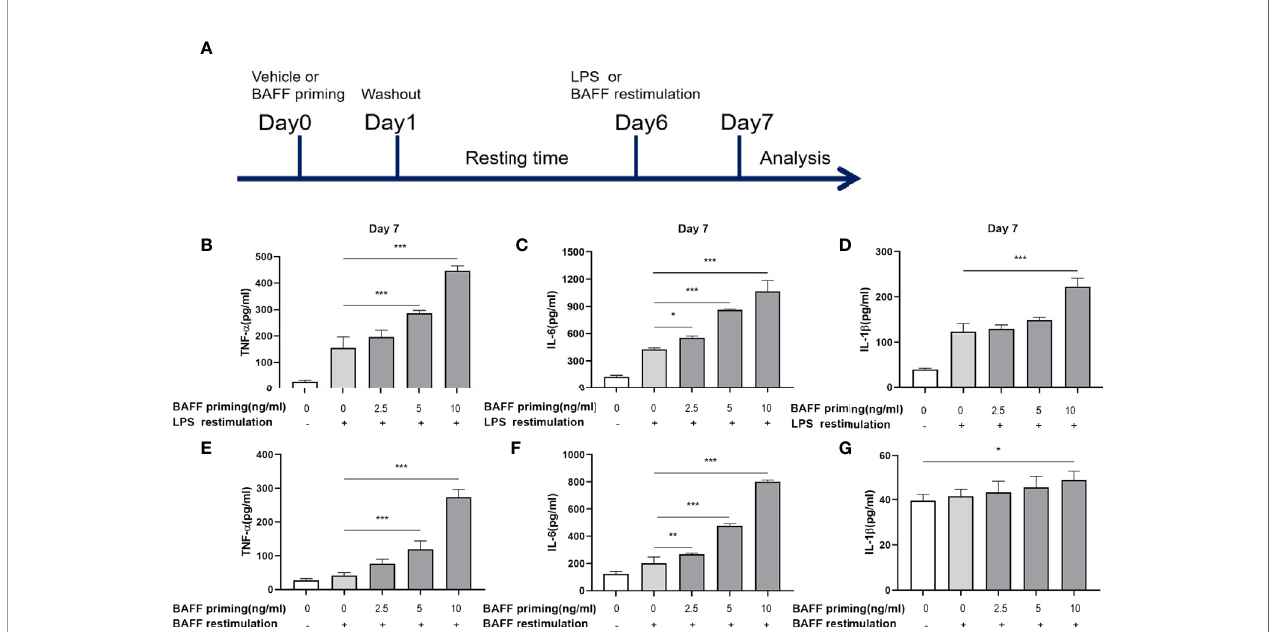
FIGURE 1 | BAFF priming induced a proin fl ammatory memory response of BV2 cells to LPS and BAFF itself. (A) Graphical outline of the in vitro methods. BV2 cells or primary mouse microglial cells were incubated for 24 h with vehicle or BAFF (de fi ned as ‘ BAFF priming ’ ), and after a 5-day rest period, microglial cells were restimulated with 40 ng/ml BAFF (BAFF restimulation) or 100 ng/ml LPS (LPS restimulation) for 24 h. In (B – D) , BV2 cells were primed with different doses of BAFF (2.5, 5, 10 ng/ml) or vehicle for 24 h, rested for 5 days, on day 6 treated with LPS restimulation for 24 h. TNF- a (B) , IL-6 (C) , and IL-1 b (D) were measured in the supernatants by ELISA on day 7(n = 12). On day 6, BV2 cells were restimulated with BAFF instead of LPS. On day 7, TNF- a (E) , IL-6 (F) and IL-1 b (G) were measured in the supernatants (n = 12). Data are means ± SED; Kruskal-Wallis test with Turkey post hoc test; *p < 0.05, **p < 0.01, and ***p <